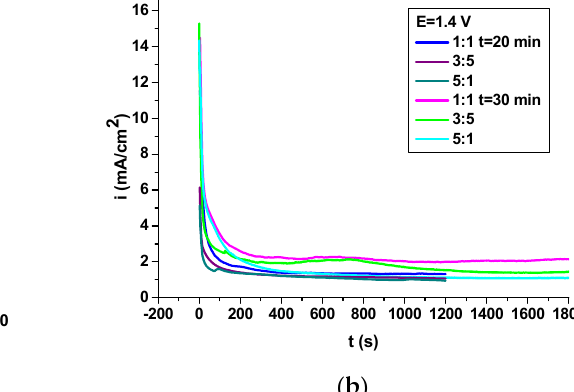
Figure 3. Cyclic voltammograms of OLC 45 electrode coated with PNMPY-TW20/P3MT in 0.3 M H 2 C 2 O 4 solution monomer free at potential interval − 0.5 and 1.5 V vs. SCE and scan rate of 20 mV/s. Studying Figure 3, it is plain that the electrochemical comportment of coating film is influenced by the number of cycles and the electrodeposition-specific features. The stead- fastness of whatever conducting polymer in reduced and oxidized states is a significant feature for numerous practices. The principal ground that determines the duration of life of a polymer is the chemical steadiness of the matrix itself. The steadiness of PNMPY- TW20/P3MT coating was appraised by cyclic voltammetry (above 20 cycles) in the oxalic acid solution without monomers (see Figure 3). The cyclic voltammetry technique was accomplished in the extensive potential range in order to explore all the physical and elec- trochemical attributes of the polymeric layers. The attendance of the oxidation and reduc- tion wave subsequent to more than 20 cycles indicates the stability of these electroactive films [4–6,10,14–22].Therefore, these layers could be cycled many times from the oxidized and reduced property without meaningful decomposition of the composite coatings; the current density lessens with either cycle and, lastly, attains a constant value.